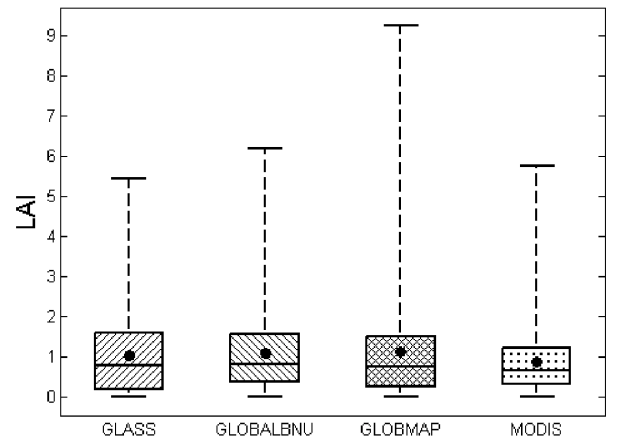
Figure 6. Boxplot of each LAI climatology. The lines (from top to bottom) represent the maximum LAI value, 75% quartile value, median value, 25% quartile value, and minimum value, respectively, and the black spot represents the mean value .